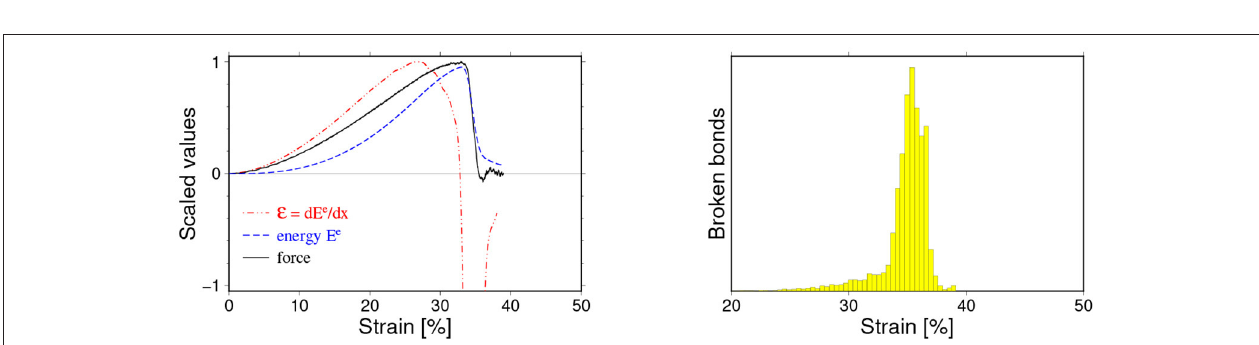
FIGURE 10 | An example of loading curves for the pure brittle cleavage-like breaking mechanisms (see Figure 7 for the description). In this case, the fracture occurs at very small deformations and is very well-localized around the critical strain x c . The particle-particle interaction parameters for this case read: k n = 10 N/mm, b d = 0.1 mm.